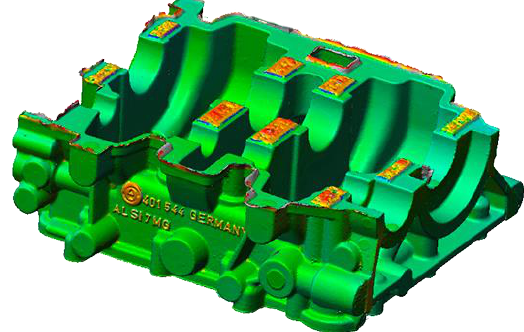
Figure 21: Color deviation map of a